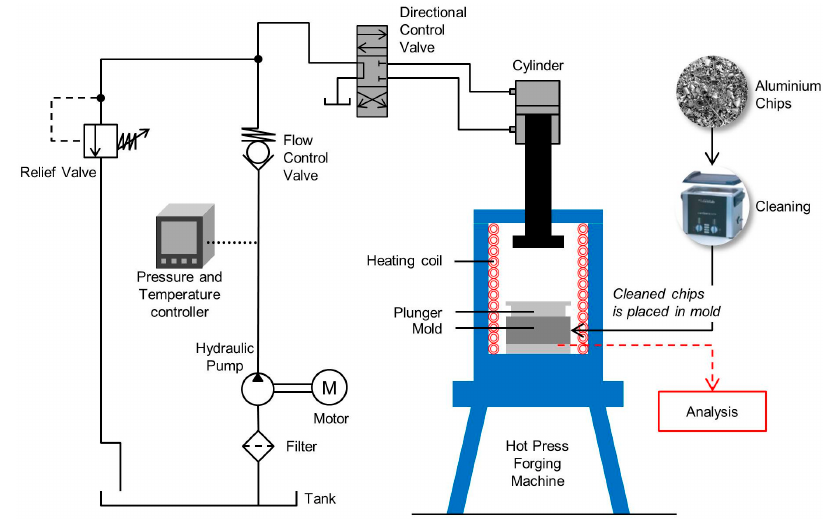
Figure 1. Direct recycling hot press process.